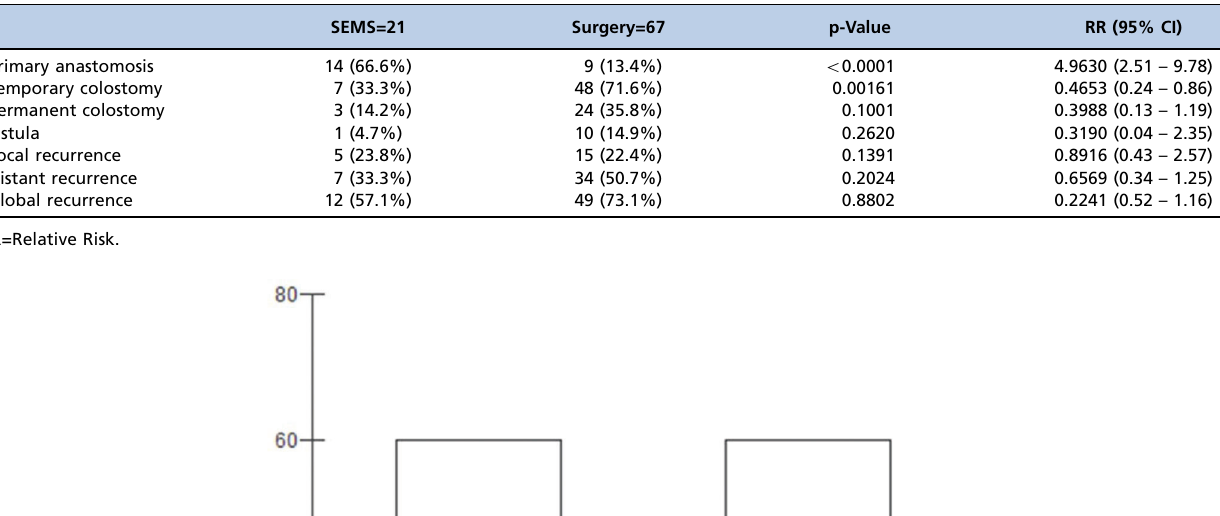
Table 3 - Comparison of surgical outcomes in SEMS vs. surgery groups.